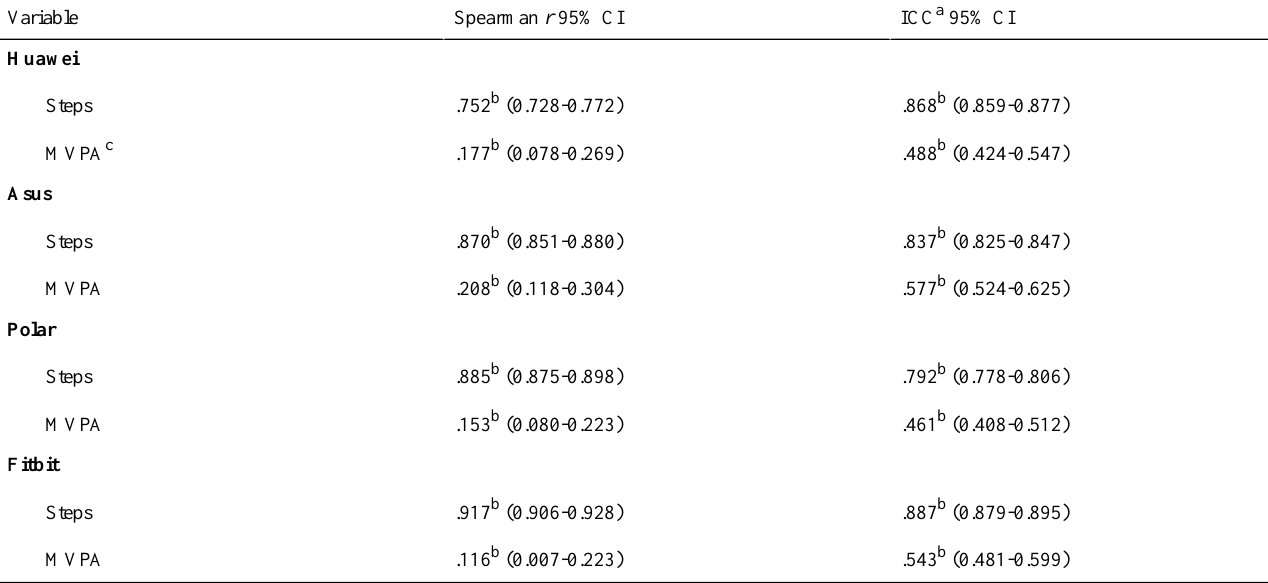
Table 5. Correlation coefficients, intraclass correlation coefficients, and 95% CIs of measurements at a 15-min